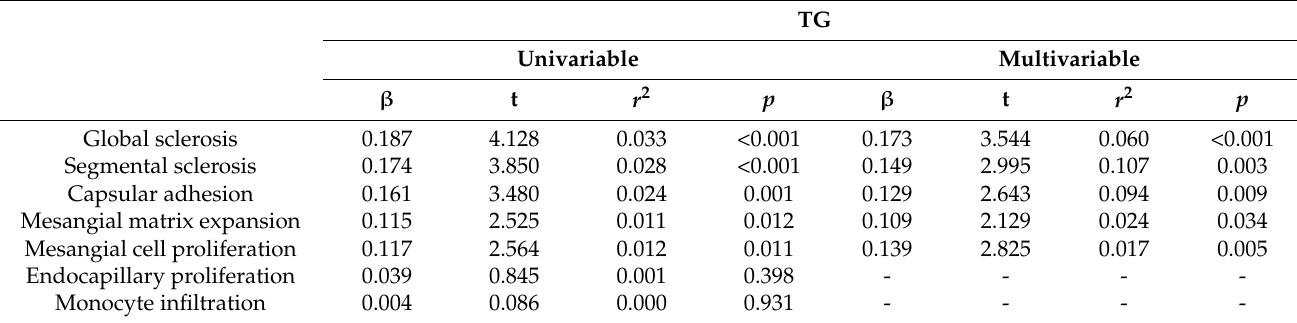
Table 6. Linear regression analysis for TGs and the histopathologic